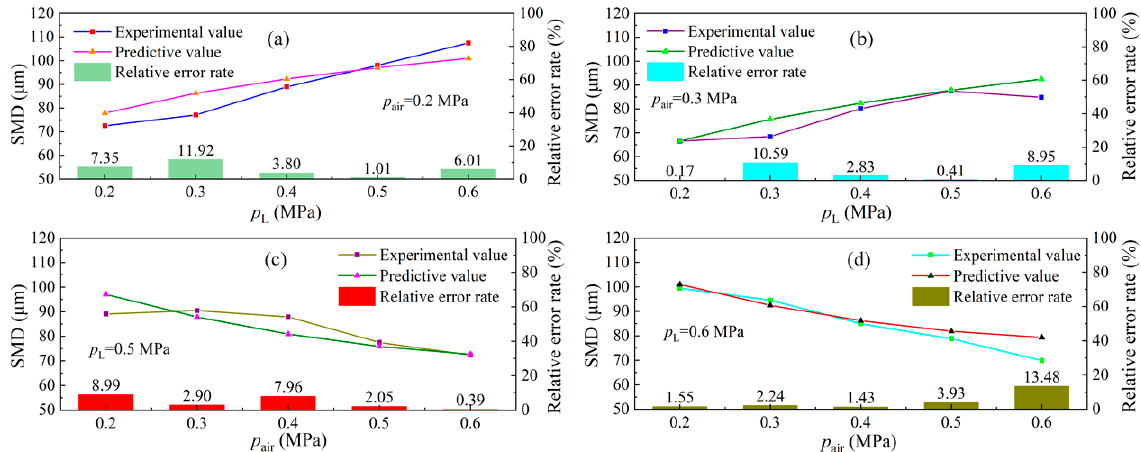
Figure 7. The predicted and experimental values of SMD for different air-water pressure nozzles: ( a ) p air = 0.2 MPa; ( b ) p air = 0.3 MPa; ( c ) p L = 0.5 MPa and ( d ) p L = 0.6 MPa.